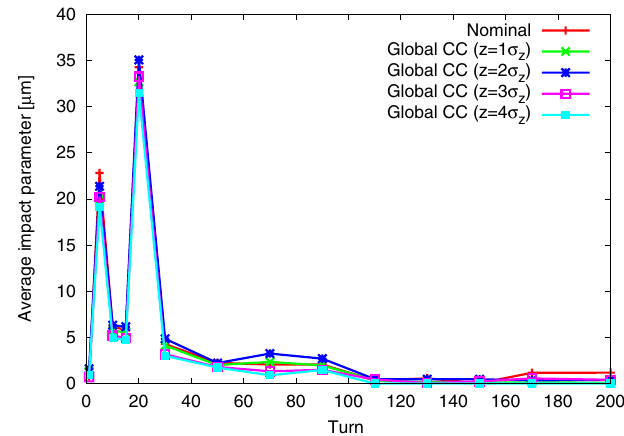
FIG. 24. (Color) Average first-time impact parameter at speci- fied turn for different cases. All cases have a 1 (cid:7) m impact parameter for the first turn.